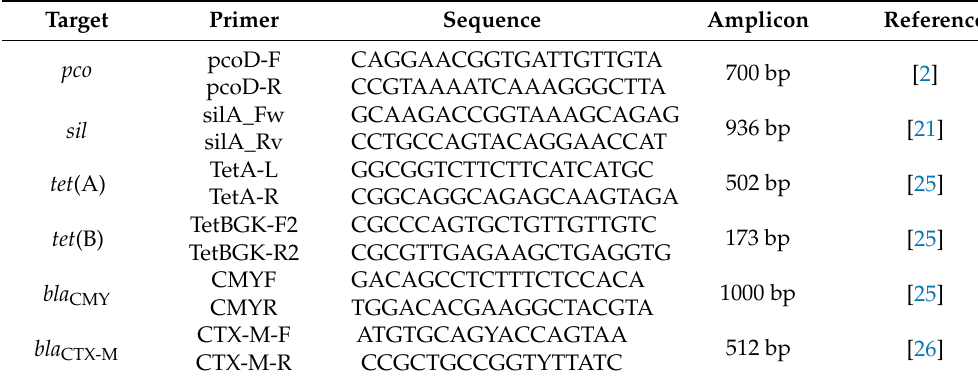
Table 1. PCR targets and primers used for detection of pco , sil , and antimicrobial resistance